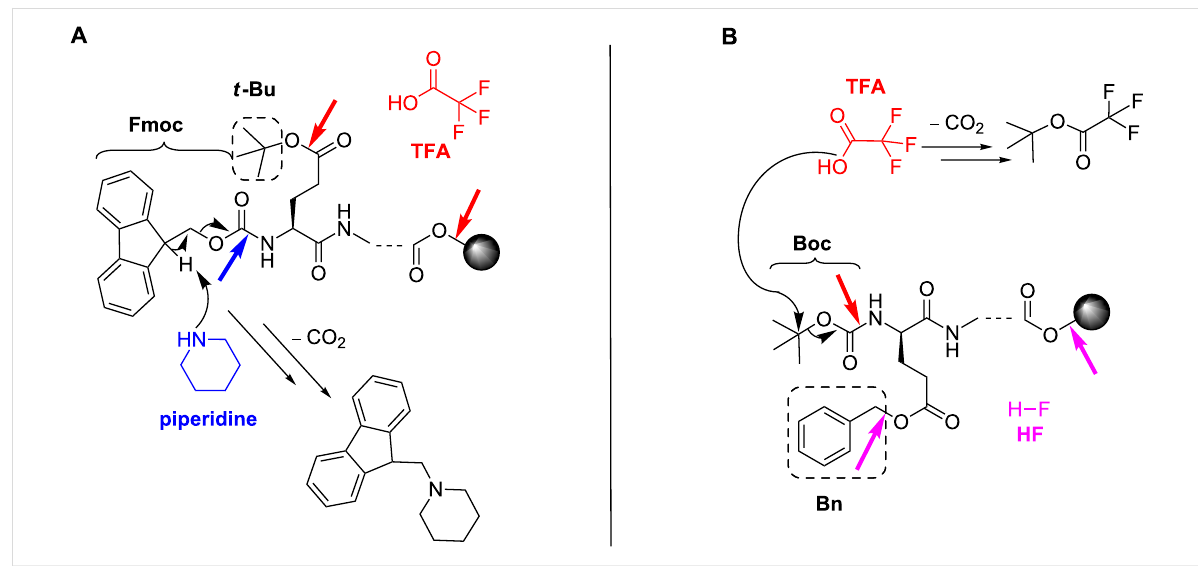
respective protecting groups are illustrated. Blue arrows indicate basic and red/purple arrows indicate acidic conditions. Dashed boxes stress the COOH-side-chain protecting group of glutamic acid exemplarily, used in each strategy.